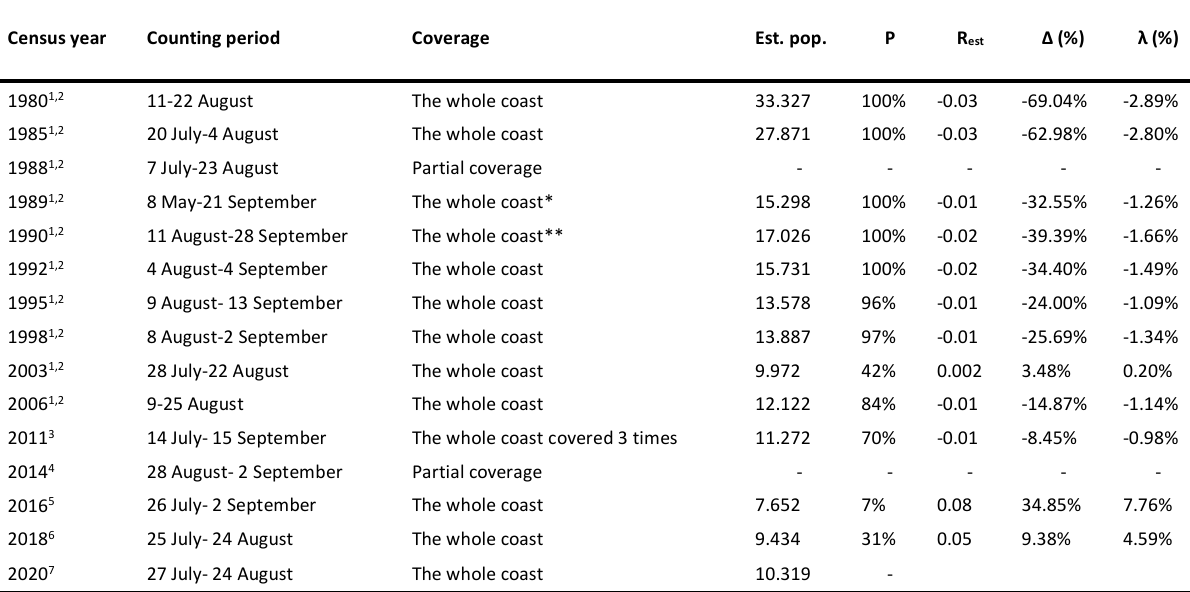
Table 1: Timing and coverage of the harbour seal censuses conducted around Iceland between 1980 and 2020. ( 1 Hauksson, 2010; 2 Hauksson & Einarsson, 2010; 3 Granquist et al., 2011; 4 Granquist et al., 2014; 5 Þórbjörnsson et al., 2017; 6 Granquist & Hauksson, 2019; 7 Granquist, 2021a), estimated population sizes (Est. pop.) for respective year from 1980 to 2020, the probability of the most recent population estimate (from 2020) being lower than previous estimates P(pop2020<popyearX), exponential growth rate (R est ), with linear percent change (Δ (%)) and discrete time per capita growth rate (λ (%)) for each year compared to